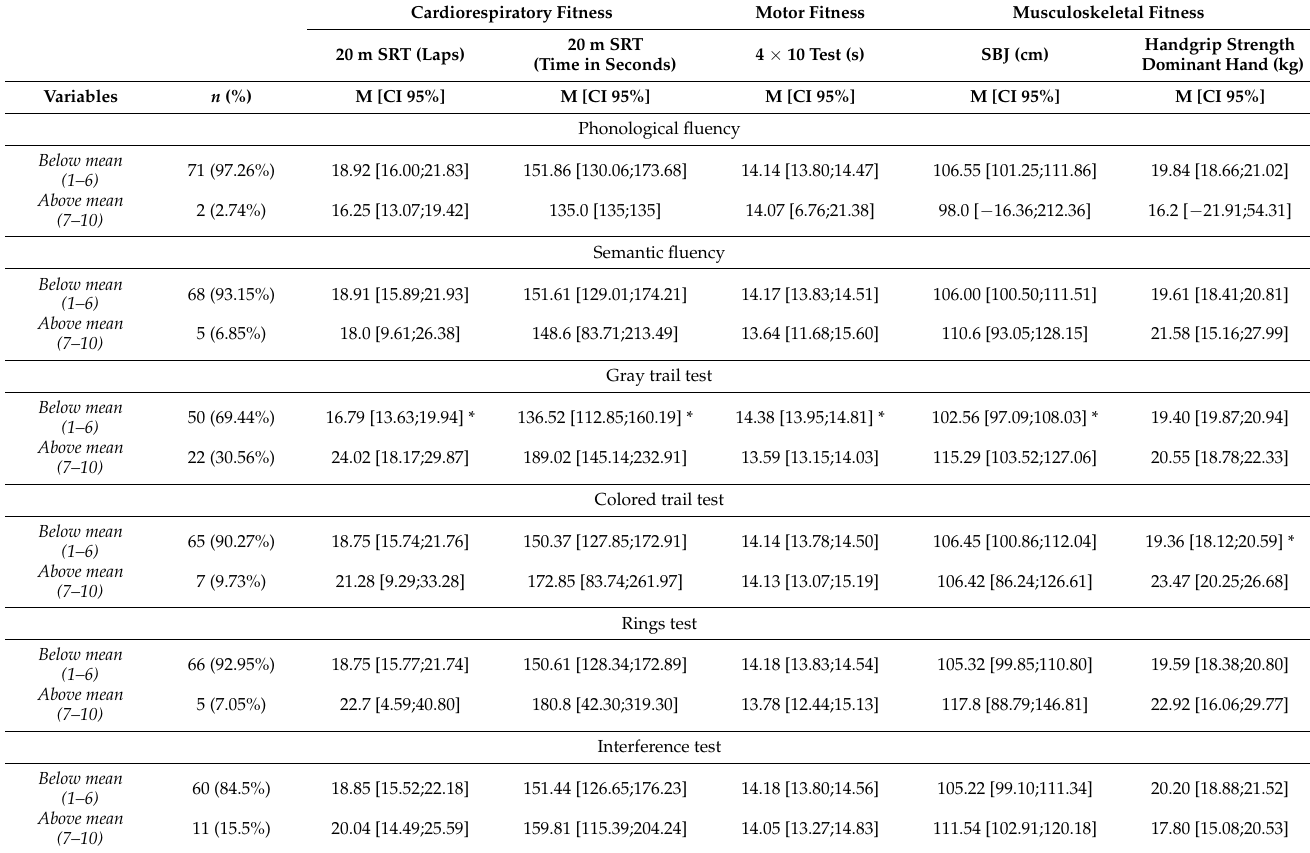
Table 3. Physical fitness according to ENFEN test